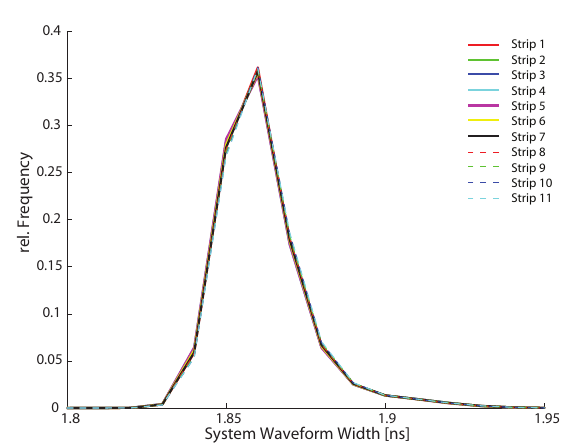
Figure 4: Histogram of the system waveform widths s s per flight strip in the 2004 campaign (bin size: 0 . 01 ).